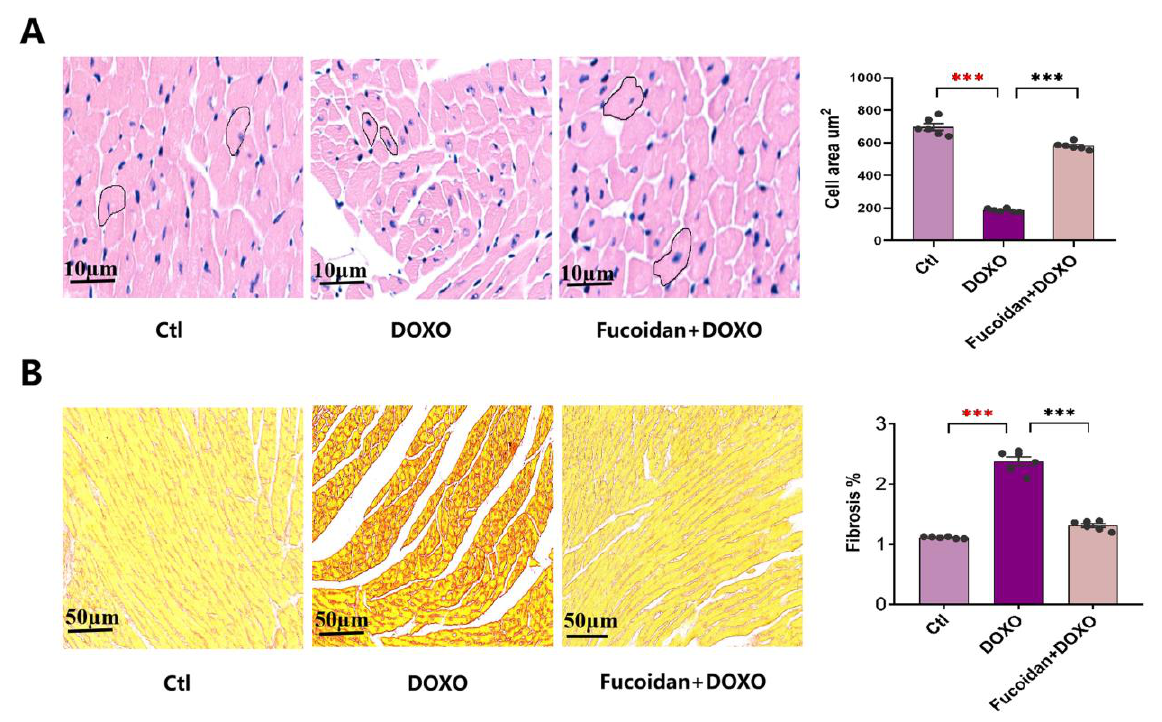
Figure 2. Effects on cardiac myocytes size and cardiac fibrosis of three groups, and fucoidan can improve DOXO-induced myocardial damage. ( A ) The cardiac myocardial cell area of ctl, DOXO and DOXO + fucoidan groups observed by H&E staining. ( B ) The rates of cardiac fibrosis of ctl, DOXO and DOXO + fucoidan groups observed by PicroSirius red staining. Each experiment was repeated in 6 samples. *** p < 0.001. The red asterisk is used to indicate the difference between the DOXO group and the Ctl group, and the black asterisk is used to indicate the difference between the DOXO group and the Fucoidan + DOXO group.